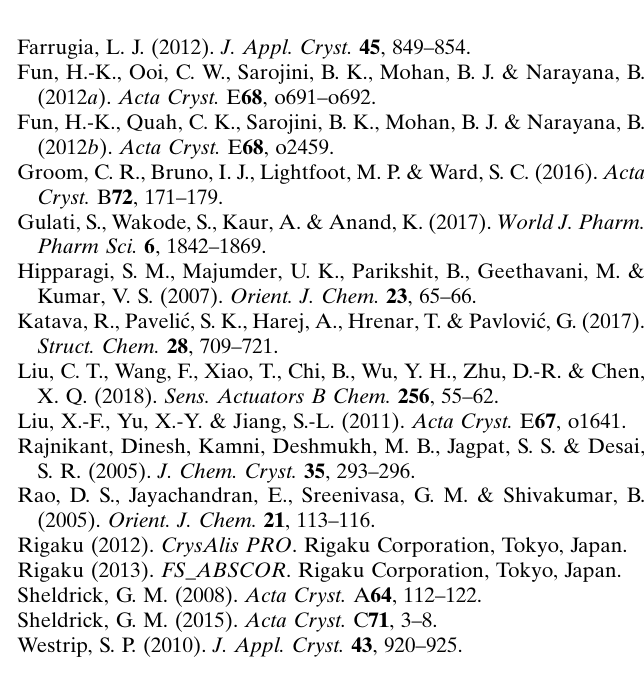
Crystal data Chemical